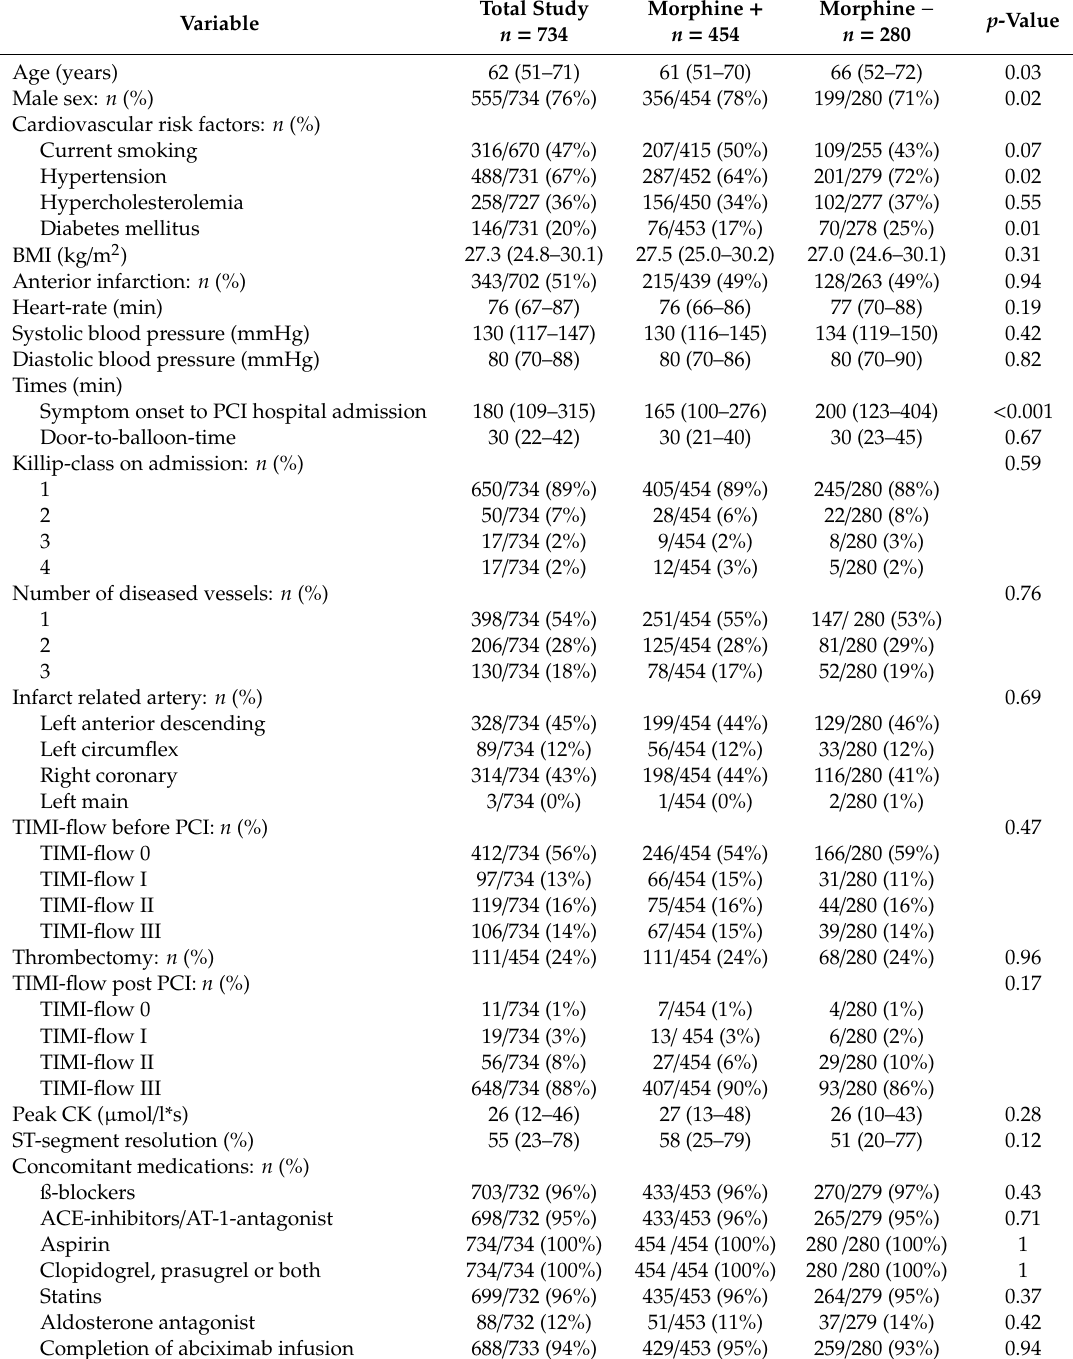
Table 1. Patient